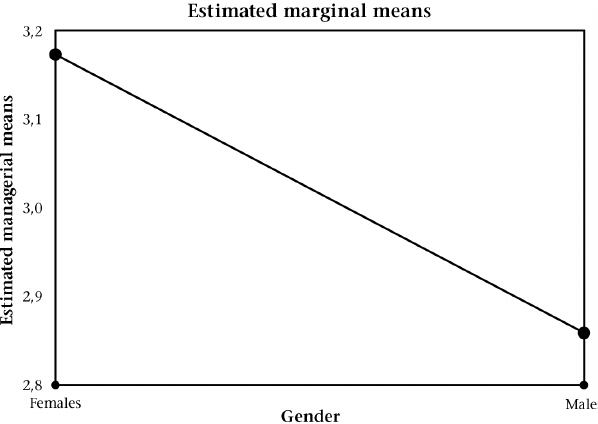
Figure 3: Biographical variable: Gender as predictor of the perception of employment equity